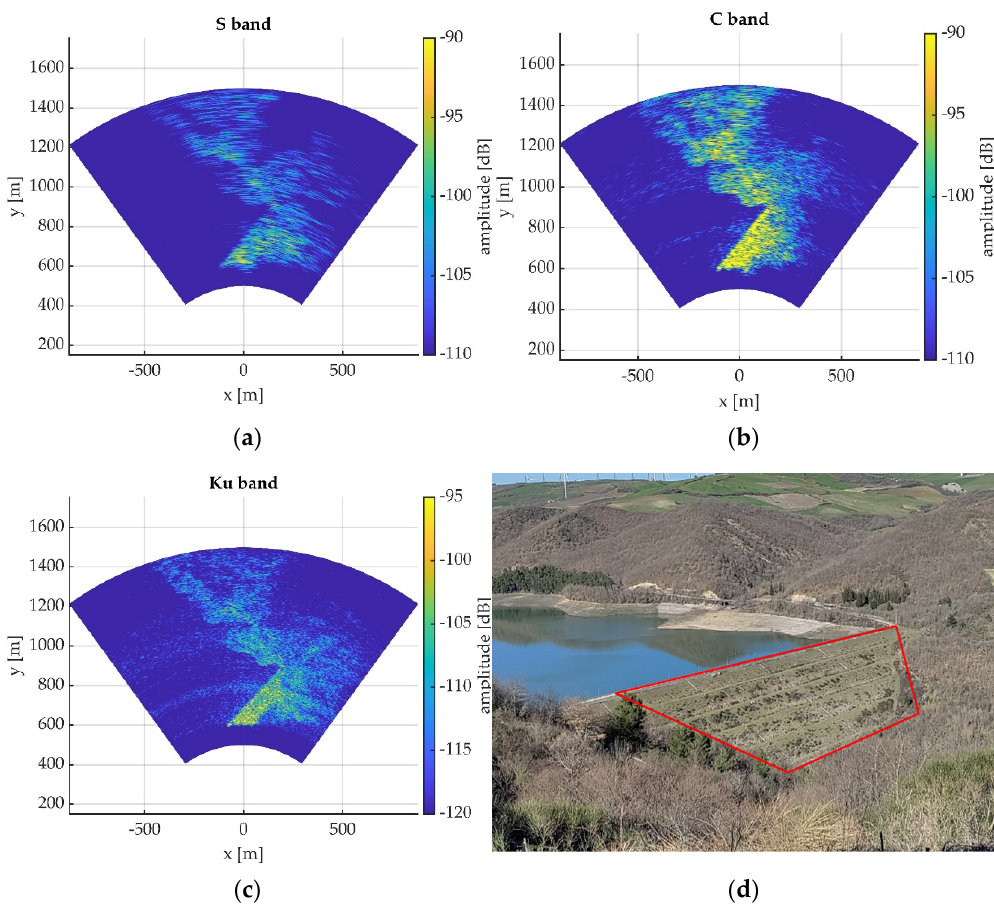
Figure 6. Amplitude GBSAR images of a vegetated dam, acquired at Aquilonia (Avellino), Italy, in S-band ( a ), C-band ( b ), and Ku-band ( c ). ( d ) shows a top view of the investigated area. The area highlighted in red was chosen for the analysis.